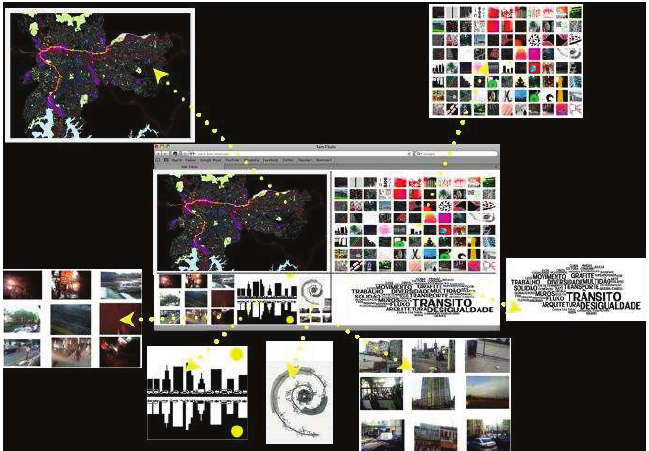
Fig. 1. Interactive and collaborative map of S˜ao Paulo